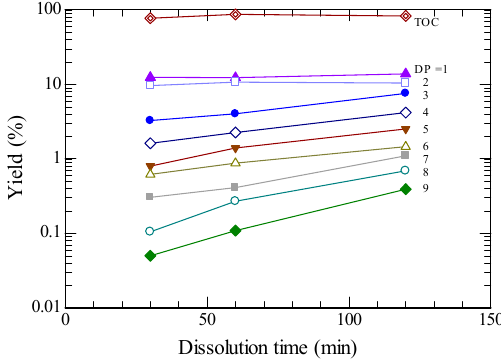
Figure 7. Effects of dissolution time on product yields and TOC.